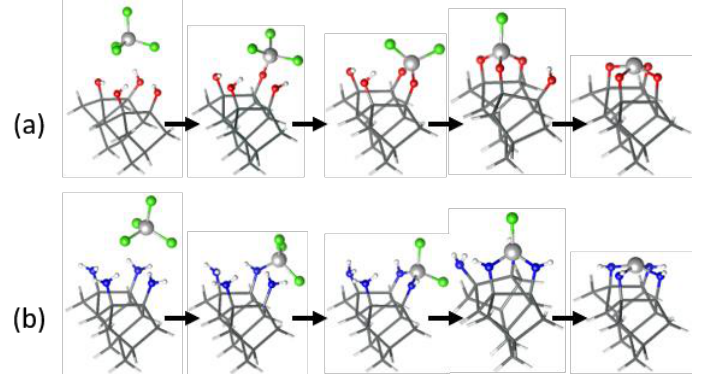
Figure 4. Considered adsorption structures for the sequential adsorption of TiX 4 : ( a ) –OH functionalized Si surface; and ( b ) –NH 2 functionalized Si surface: (1) Molecular adsorption; (2) desorption of first HX; (3) desorption of second HX; (4) desorption of third HX; and (5) desorption of fourth HX.